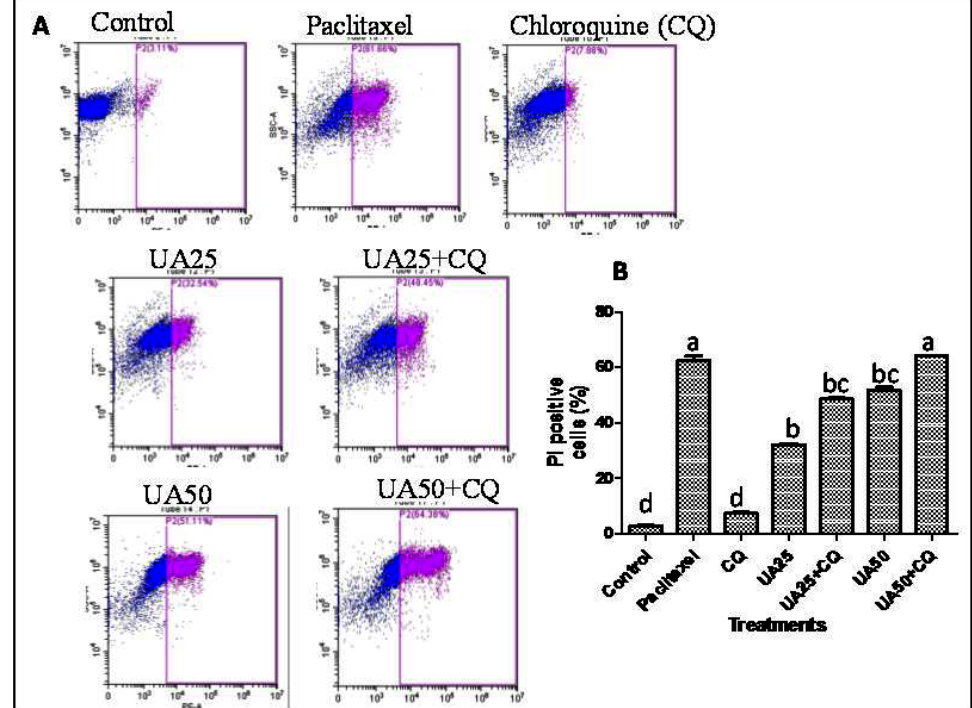
Figure 6. Cytotoxic effect of usnic acid (UA) against HeLa cells in the presence of chloroquine (+/ − CQ) via PI live/dead FACS analysis after 24 h of treatment. ( A ) FACS plot of UA-treated (+/ − CQ) HeLa cells. ( B ) Bar graph representing PI-positive cells after UA treatment (+/ − CQ). Values are the means ± SD of three independent experiments. Means sharing different letters differ significantly from each other at p ≤ 0.05. The blur color represents PI negative cells, whereas purple color represents PI positive cells.